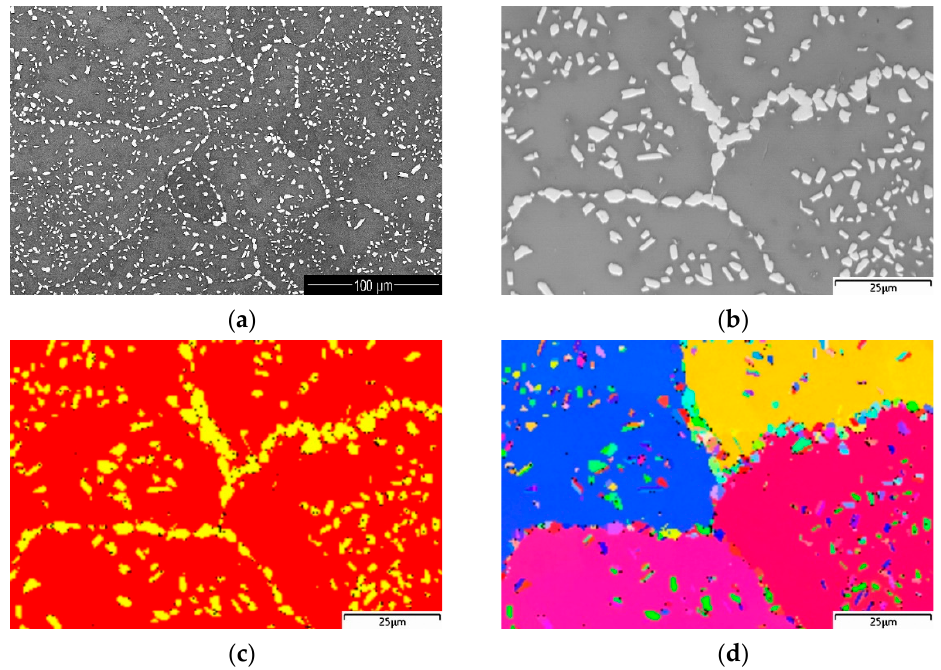
Figure 6. ( a ) Low-magnification and ( b ) higher-magnification BSE images of an Re 0.3 NbTiZr alloy sample after HIP’ing at 1400 °C. ( c ) EBSD phase map (BCC is red and FCC is yellow) and ( d ) combined inverse pole figure (IPF) orientation map of the BCC matric phase and FCC particles in the area shown in ( b ). The color-coding map of crystallographic orientations in BCC and FCC phases is shown on the right site of ( d ). Table 6. Chemical composition (in at.%) and volume fraction (V f ) of the matrix phase and particles in Re 0.3 NbTiZr after HIP’ing at 1400 °C and after additional compression deformation at 1000 °C. Condition